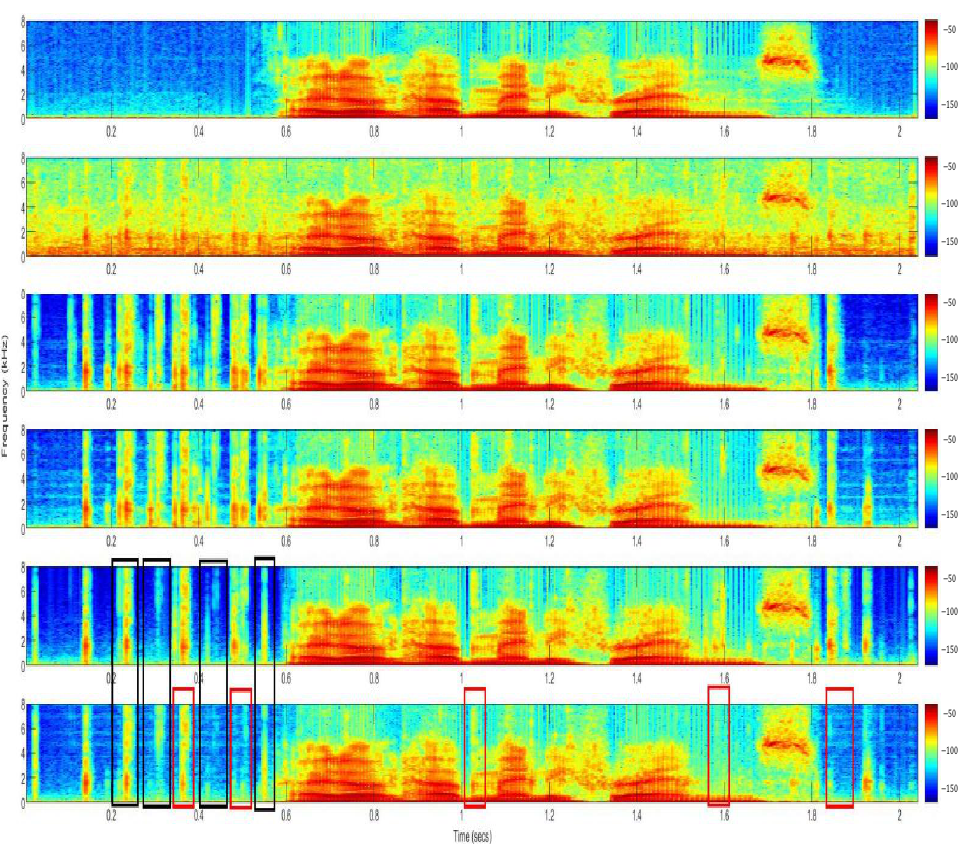
Figure 5. Spectrograms from the top to the bottom correspond to clean speech, noisy speech, enhanced speech by AECNN, SERGAN, progressive generator, progressive generator with multi- scale discriminator,